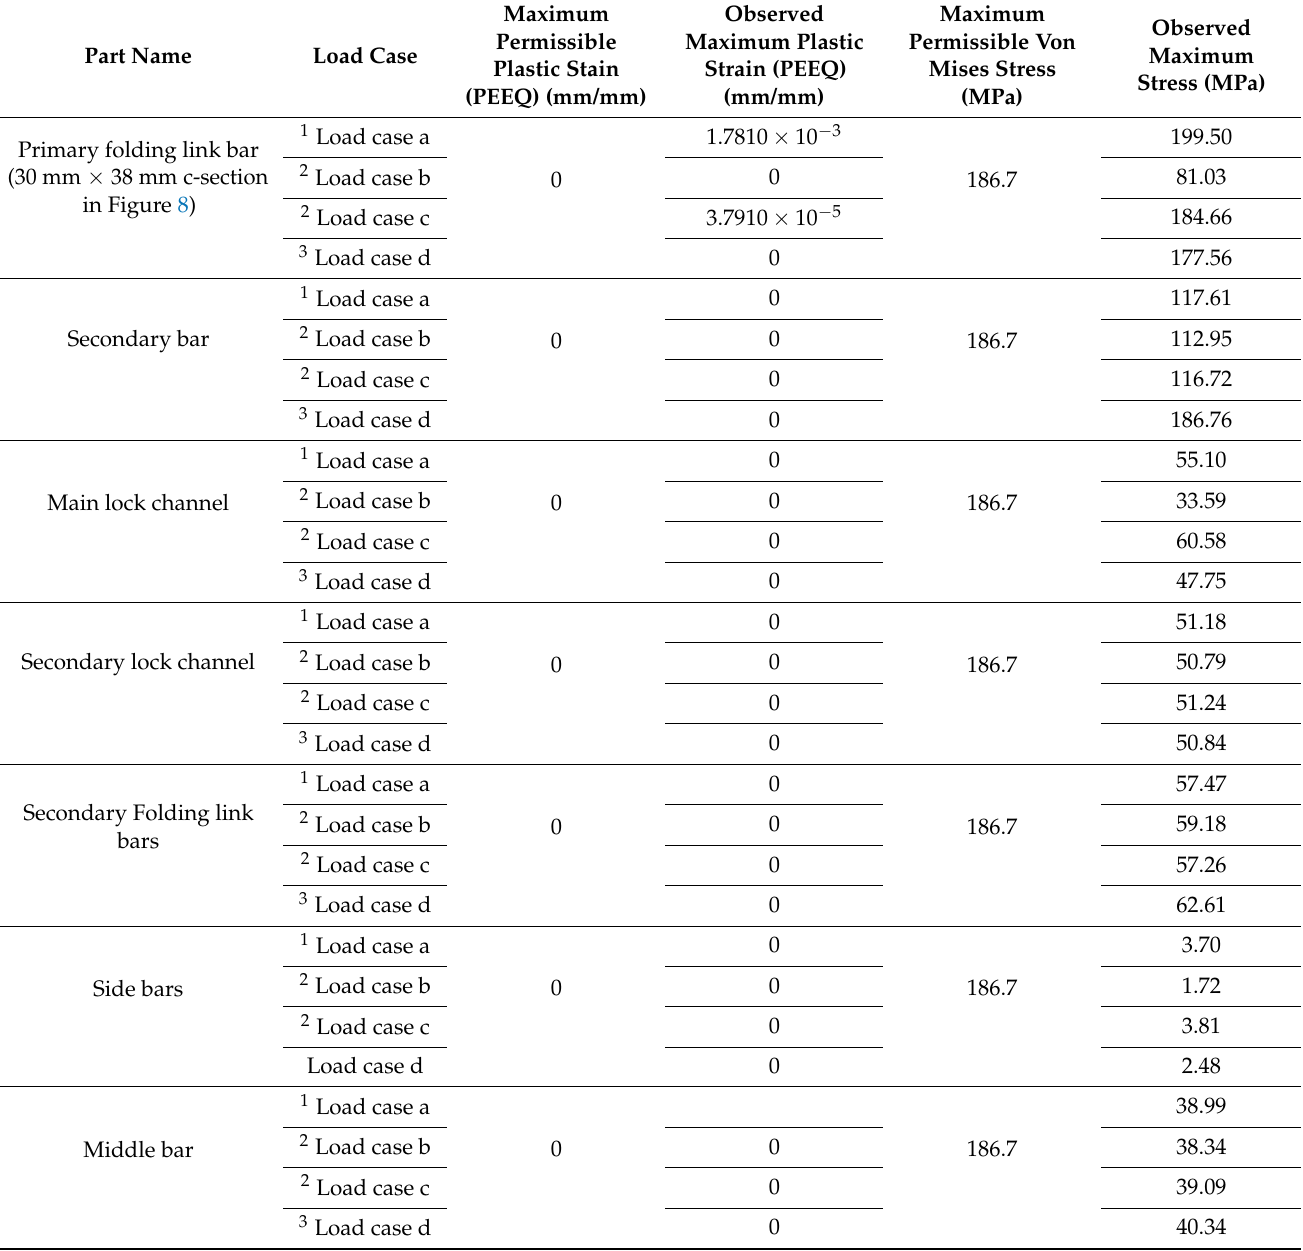
Table 1. Summary of results in different load